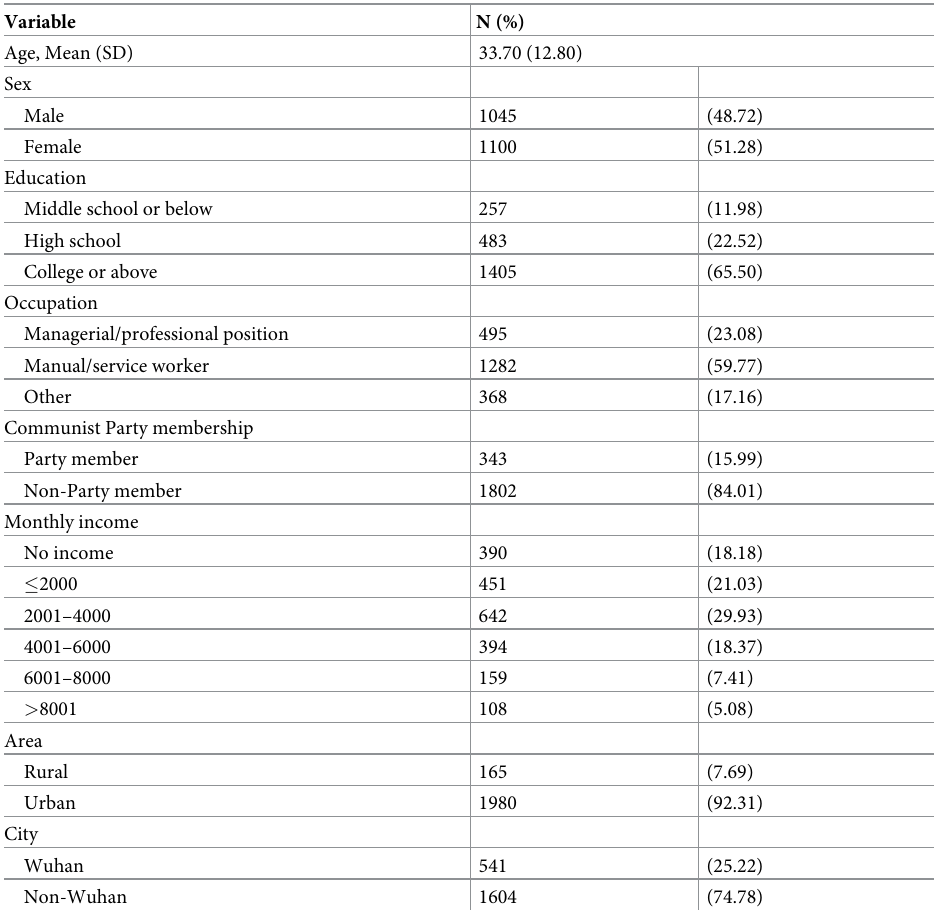
Table 1. Descriptive statistics of background